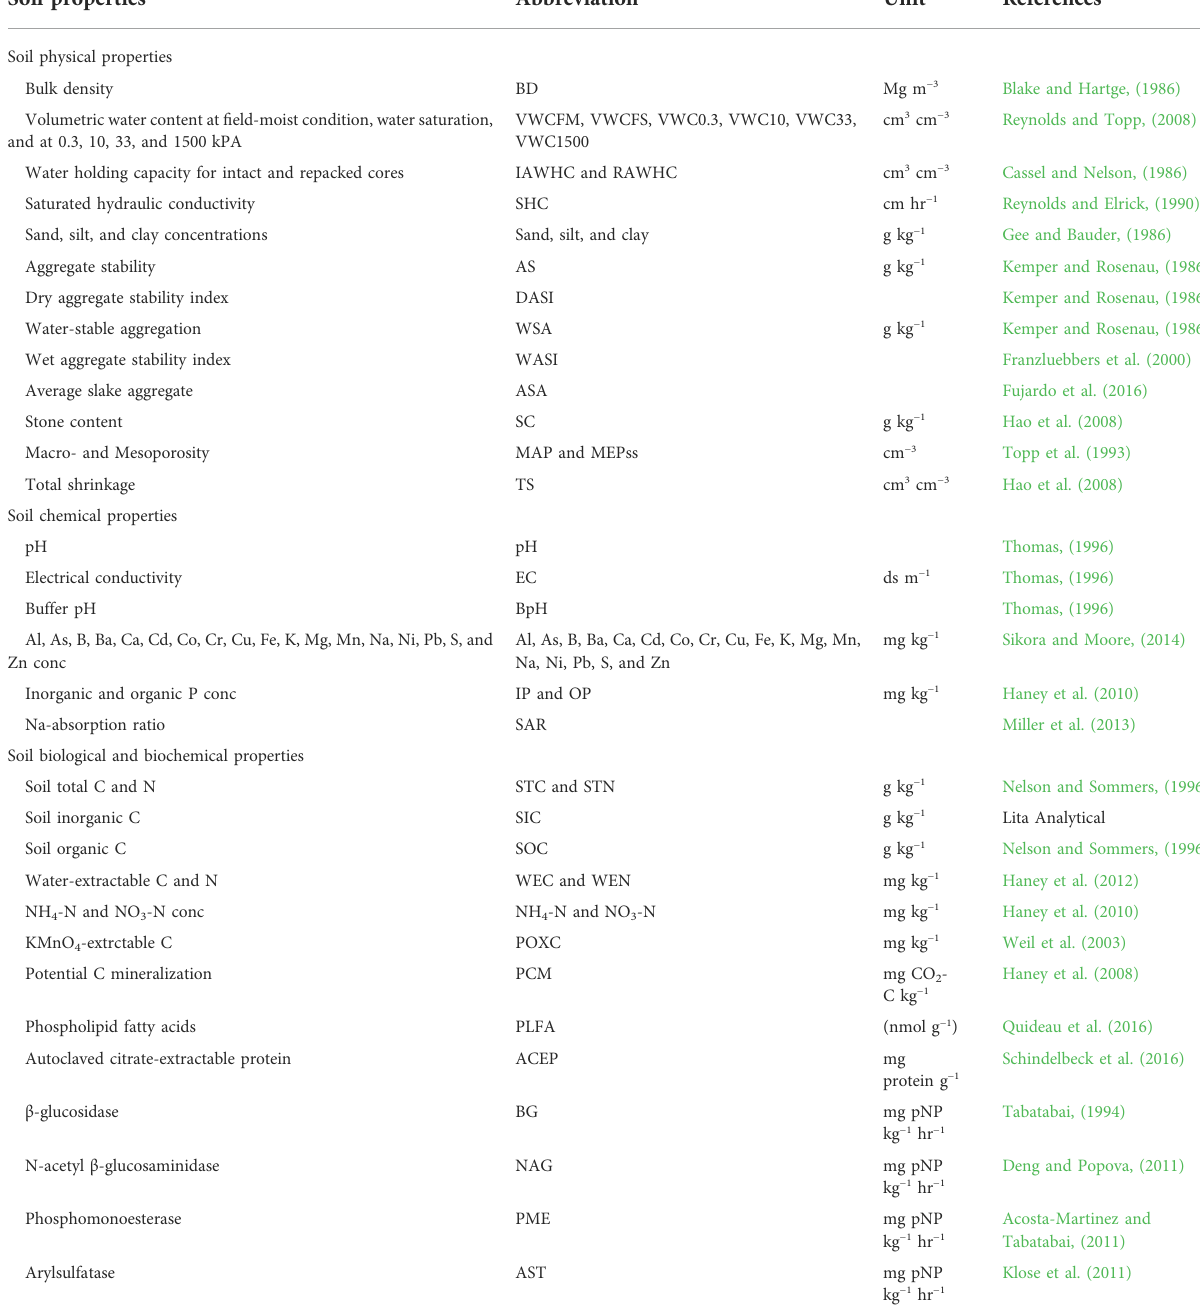
TABLE 1 Determination of soil physical, chemical, biological, and biochemical